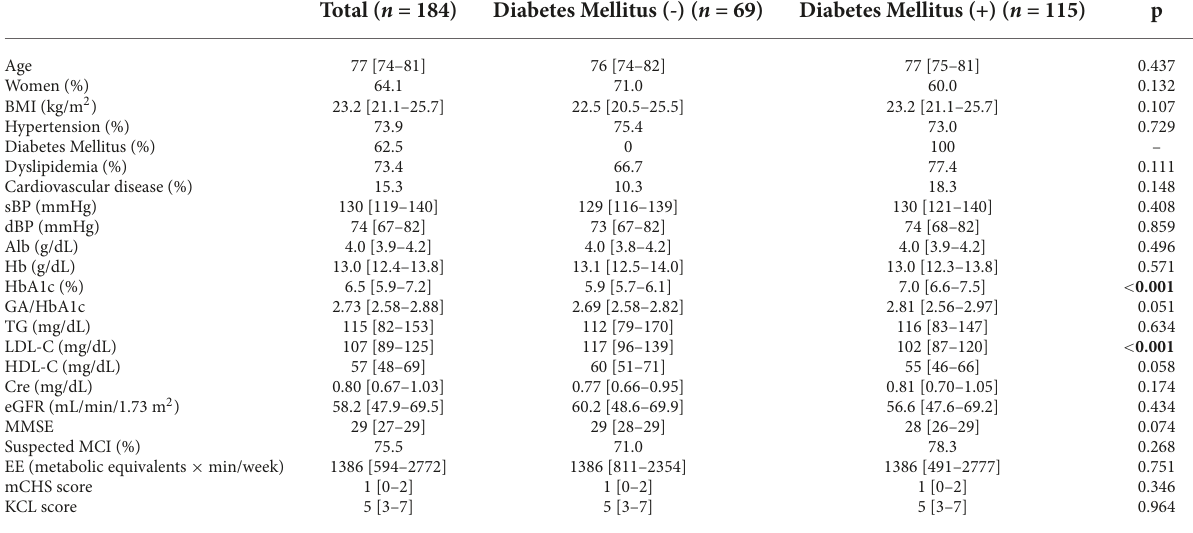
TABLE 1 Baseline clinical characteristics of the patients. Total ( n = 184) Diabetes Mellitus (-) ( n =